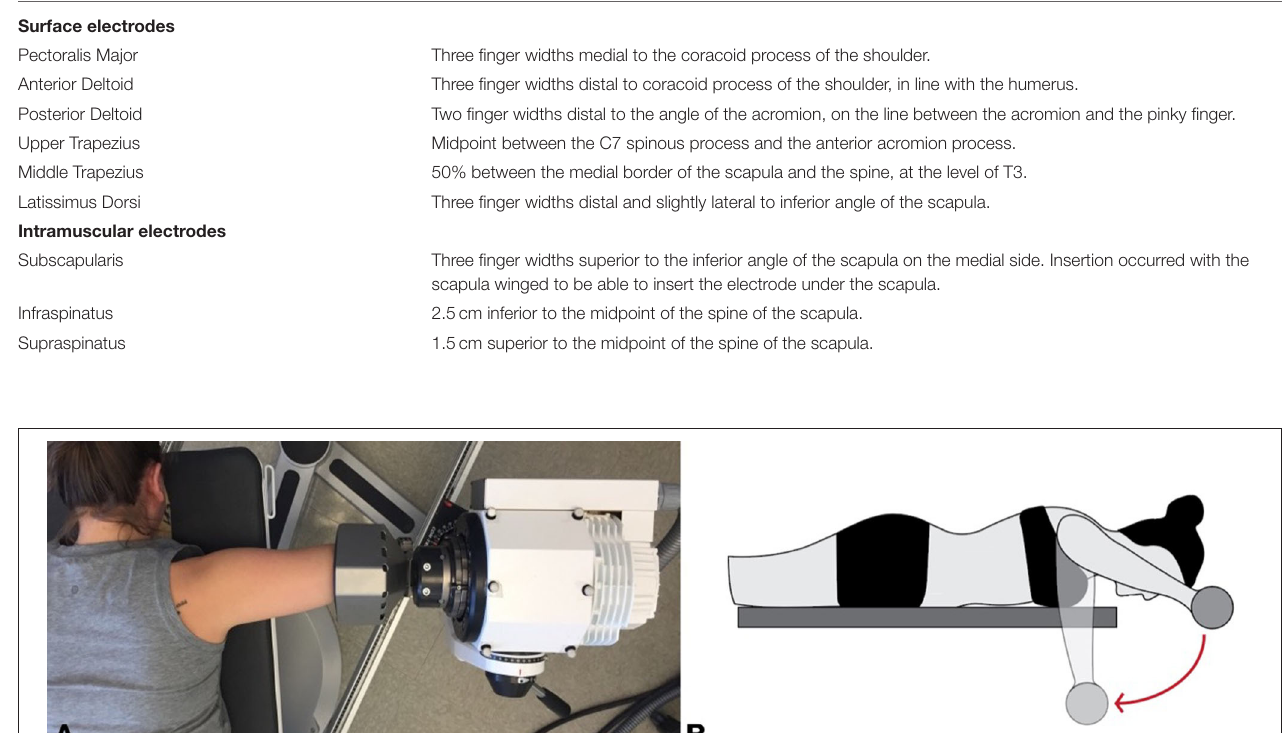
task duration between groups, followed by Bonferroni post- hoc testing. Separate Generalized Estimating Equations